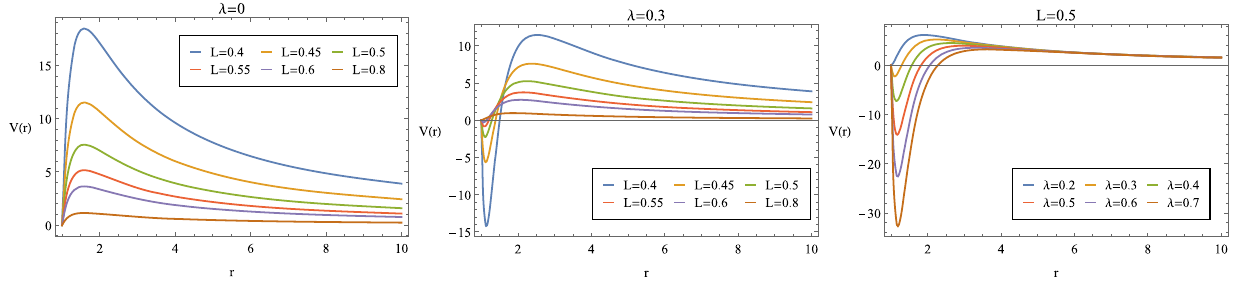
Fig. 7 The effective potential for AdS black hole with zero